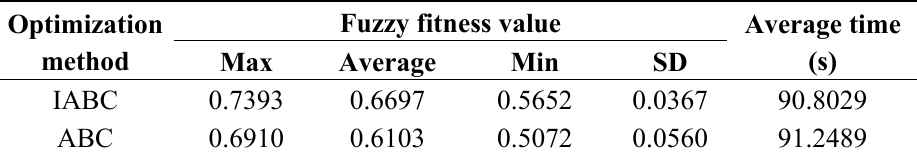
Table 8. Results obtained by the different algorithms for fuzzy multi-objective OPF for the IEEE 57-bus system.